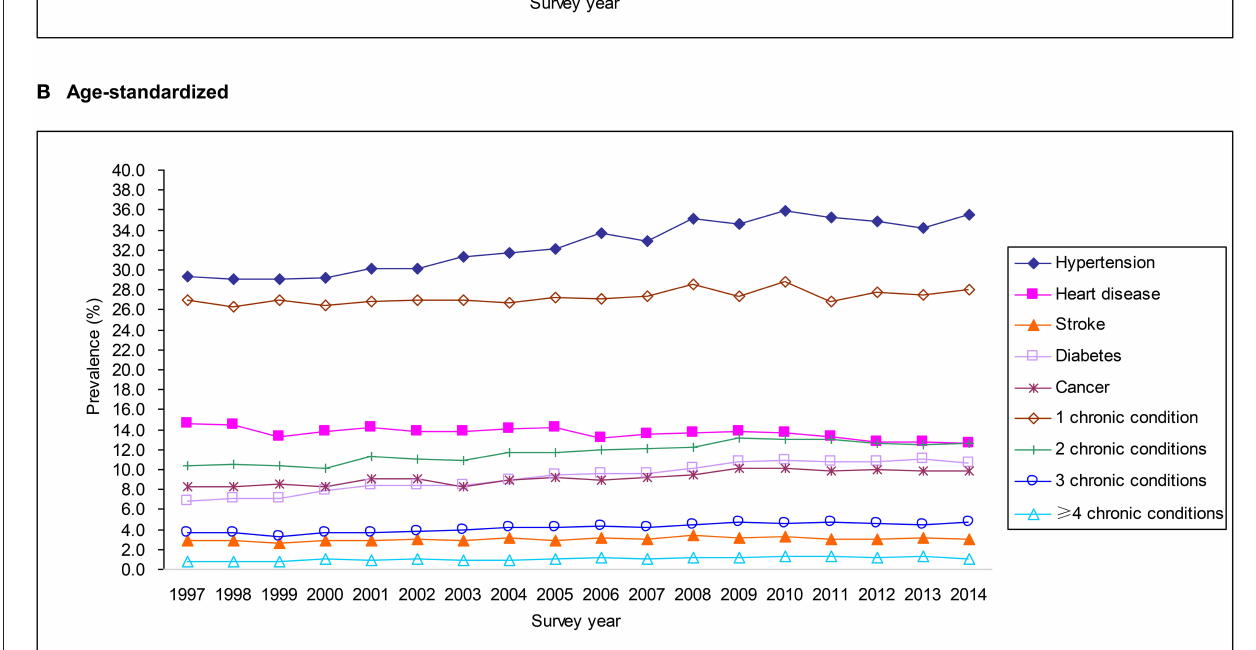
FIGURE 2 | Trends in crude (A) and age-standardized (B) prevalence of chronic conditions from 1997 to 2014 in the National Health Interview Survey.